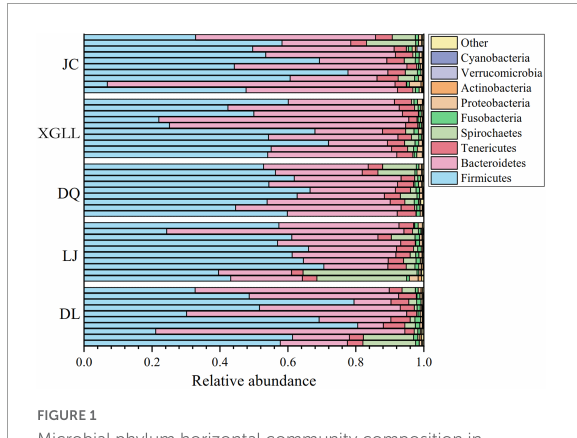
FIGURE1 Microbial phylum horizontal community composition in Eothenomys